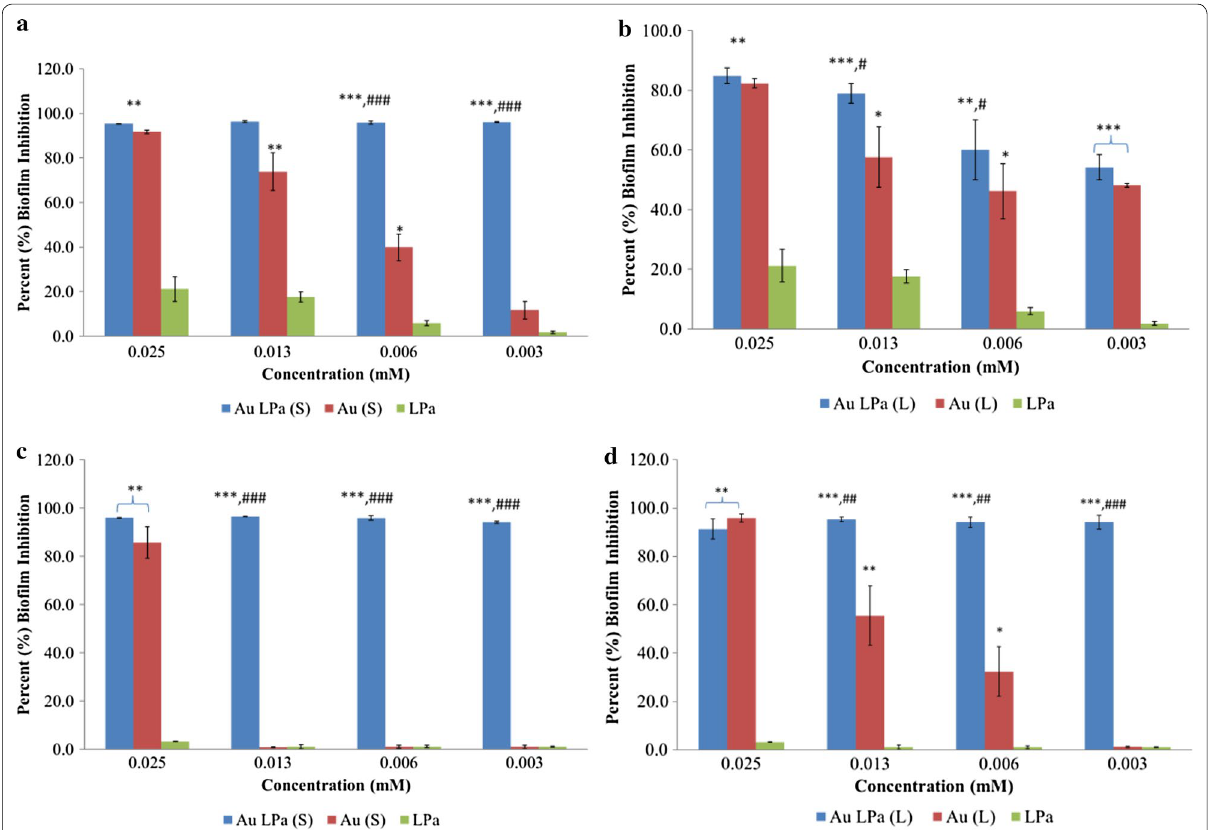
Fig. 5 Percent biofilm inhibition of Au-LPa (small and large size) against ( a , b ) S. aureus ; ( c , d ) S. mutans . Statistical significance of the data was represented as * p < 0.05, ** p < 0.01 and *** p < 0.001. Whereas * represent significance as compared to LPa and # represent as compared to gold nanomaterials alone (small or large